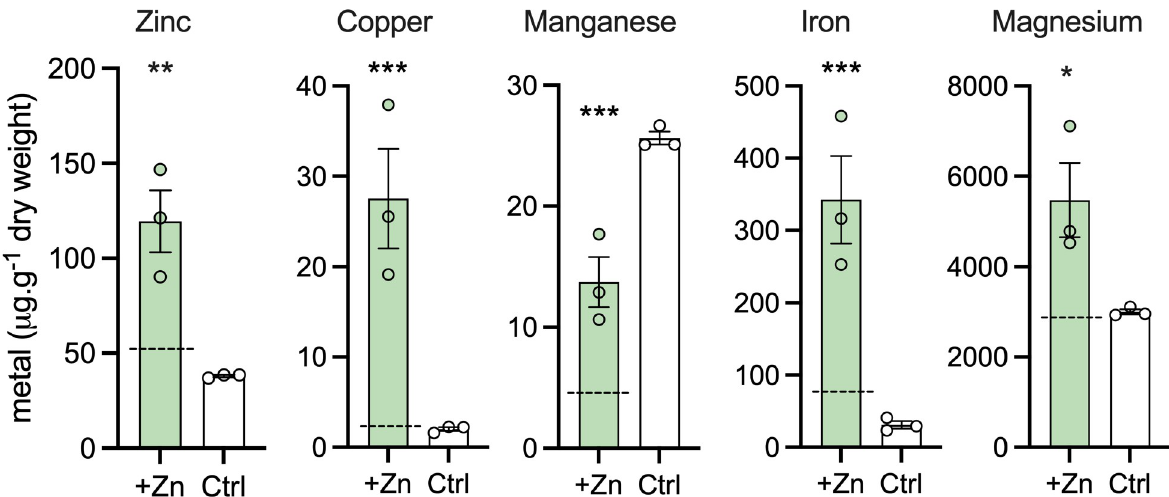
Fig 2. Accumulation of cell-associated Zn, Cu, Mn, Fe or Mg in Δ copY GBS with or without Zn stress. Δ copY GBS was exposed to Zn (0.25 mM; green bars) and cellular metal content was compared to non-exposed controls (THB only; white bars) using Inductively coupled plasma optical emission spectrometry (ICP-OES). Metal content is shown, with values normalised using dry weight of bacterial cell pellets ( μ g metal per g dry weight biomass). Bars show mean ± S.E.M ( n = 3 biological repeats). Values for each metal for Δ copY during Zn stress (+Zn) were compared to WT grown in identical conditions, by ordinary one-way ANOVA and Holm-Sidak multiple comparisons ( � P < 0.05, �� P < 0.01, ��� P < 0.001). Mean values of WT GBS in Zn stress (0.25 mM) are shown with dotted lines; values for Zn, Cu, Mn and Fe are published elsewhere [21].